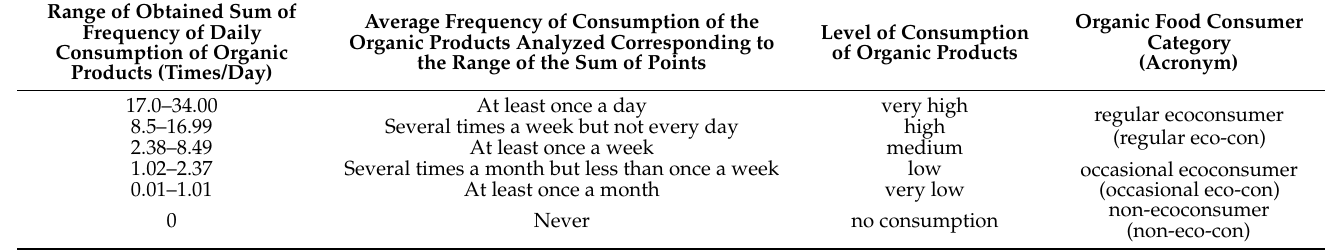
Table 2. Method of interpretation of the results obtained from the question on frequency of consump- tion of organic